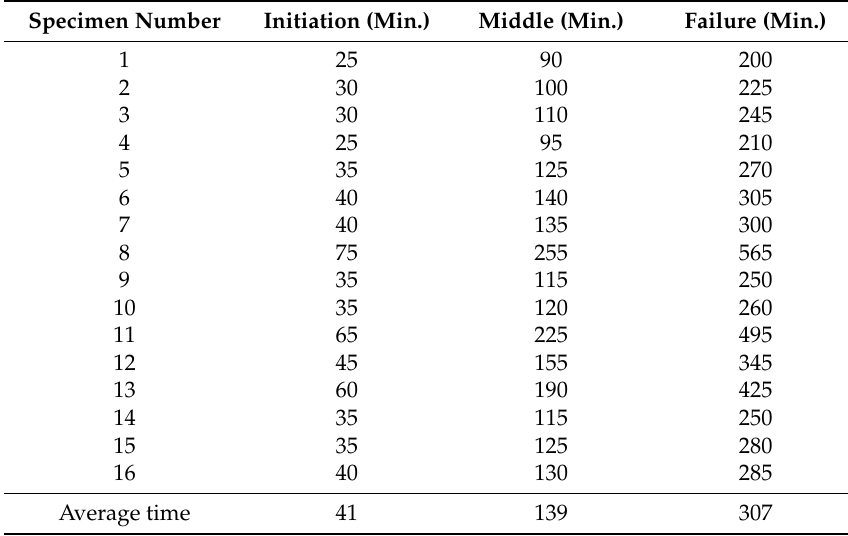
Figure 9. Time to failure of the Weibull distribution of tree model 1 (divided by three progress: initiation, middle, failure).